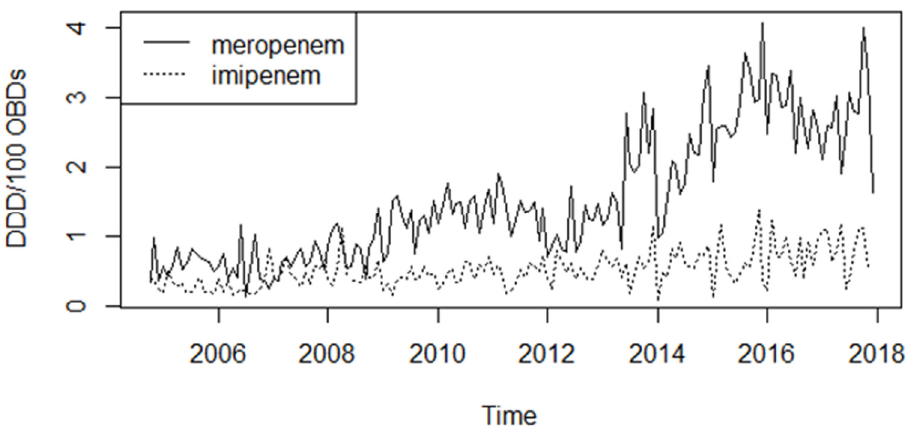
Figure 1. Changes in meropenem and imipenem consumption between 2004 and 2018 in tertiary-case in defined daily doses per 100 occupied bed-days (DDD/100 OBDs).